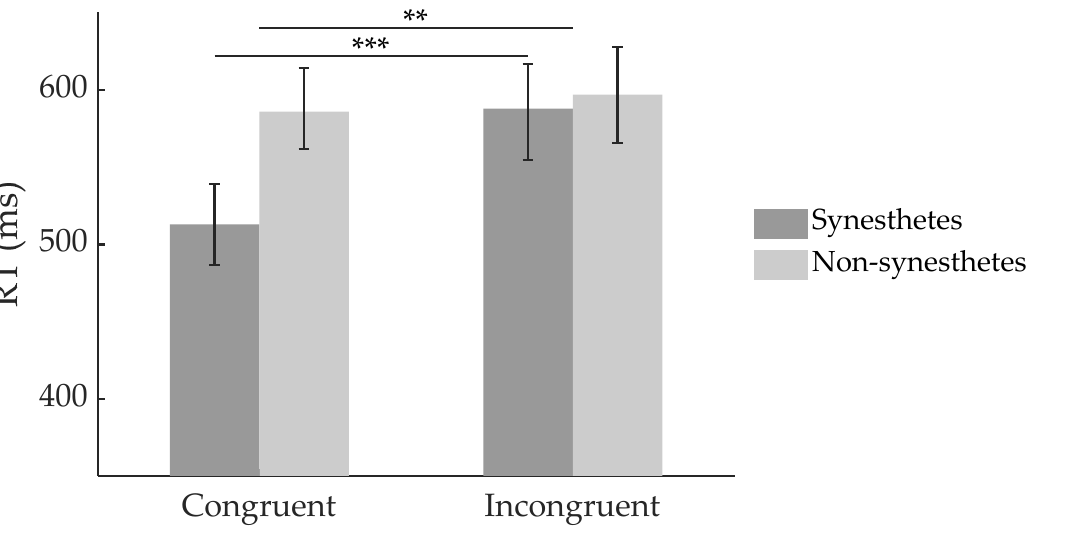
Figure 3. RTs of synesthetes and non-synesthetes in congruent and incongruent trails. Error bars denote one standard error. ** p < 0.01, *** p < 0.001.